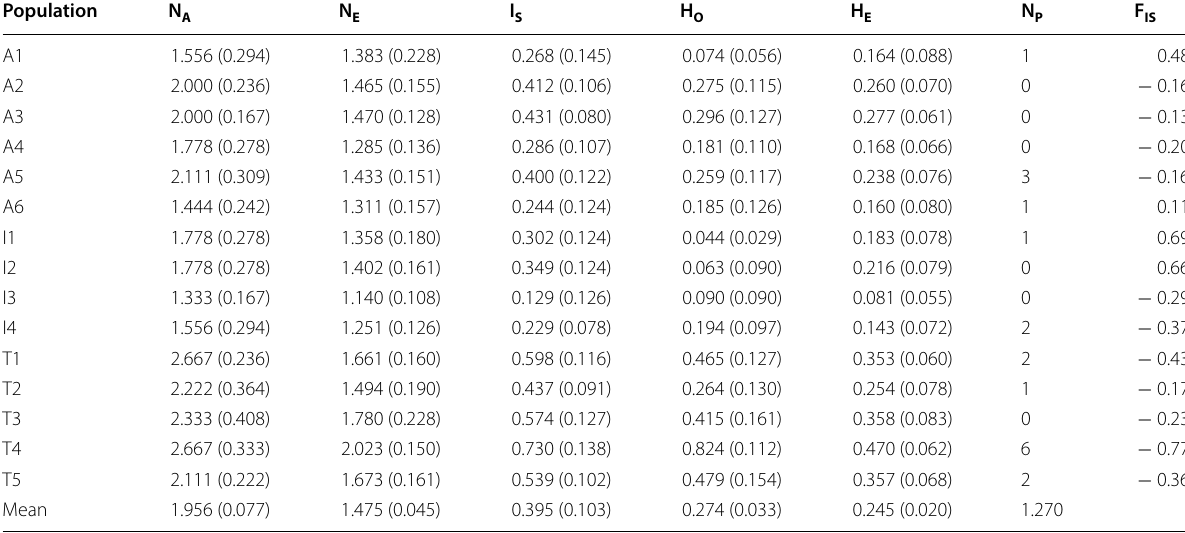
Table 2 The genetic diversity parameters measures among the 15 N. nucifera populations